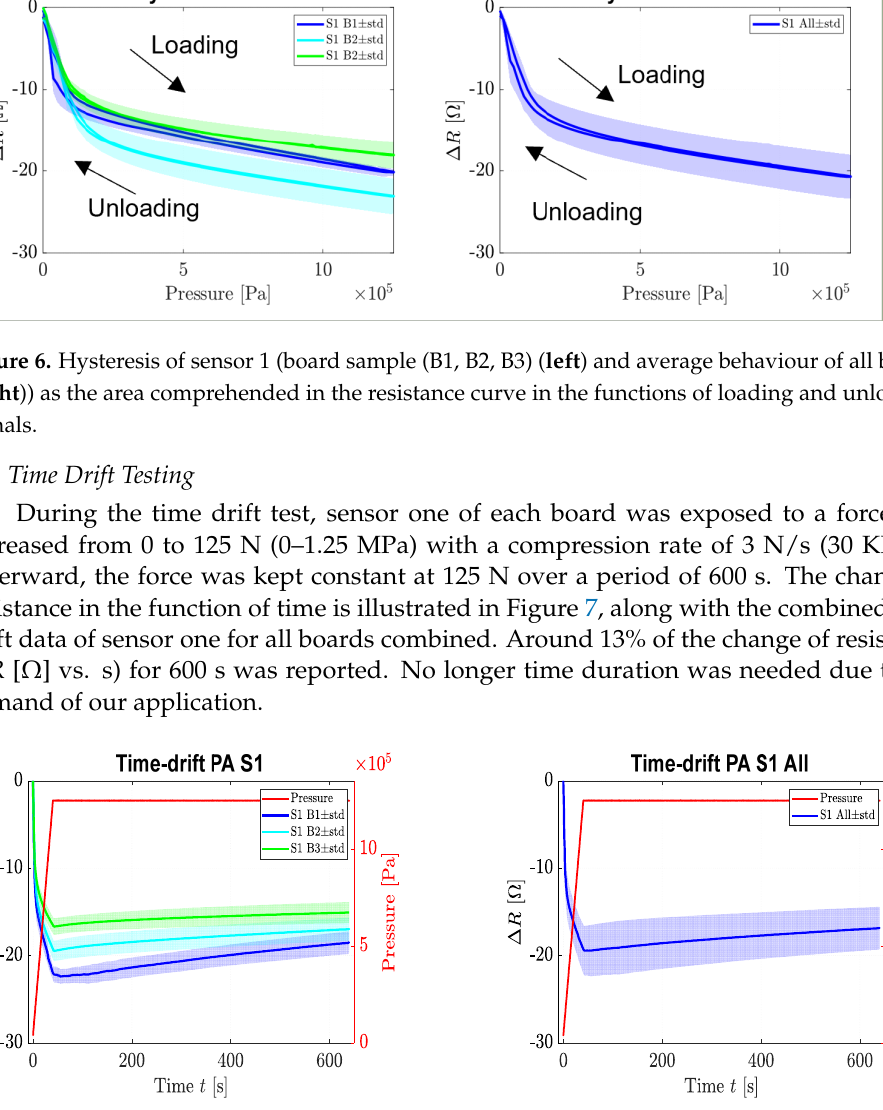
Figure 7. Time drift vs. change in resistance at 125 N in the function of time and maximum hold time of 10 min (sensor 1 (board sample (B1, B2, B3) ( left ) and average behaviour of all boards ( right